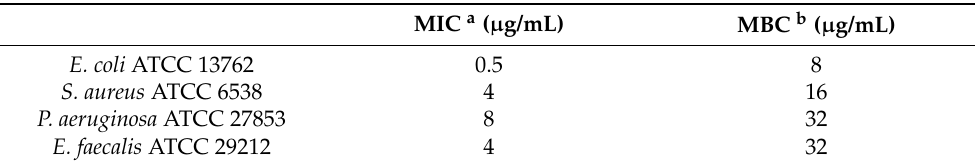
Table 1 . Antimicrobial activities of CBDA against ATCC strains. a MIC, minimum inhibitory con- centration values are expressed as concentration of CBDA. b MBC, minimum bactericidal concentra- tion values are expressed as concentration of CBDA.